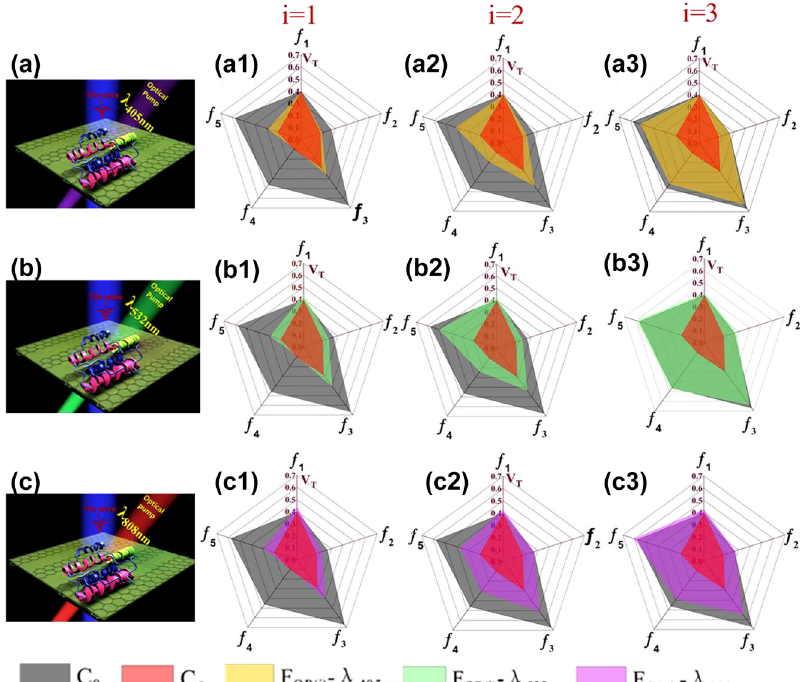
Figure 6: Description of reversible